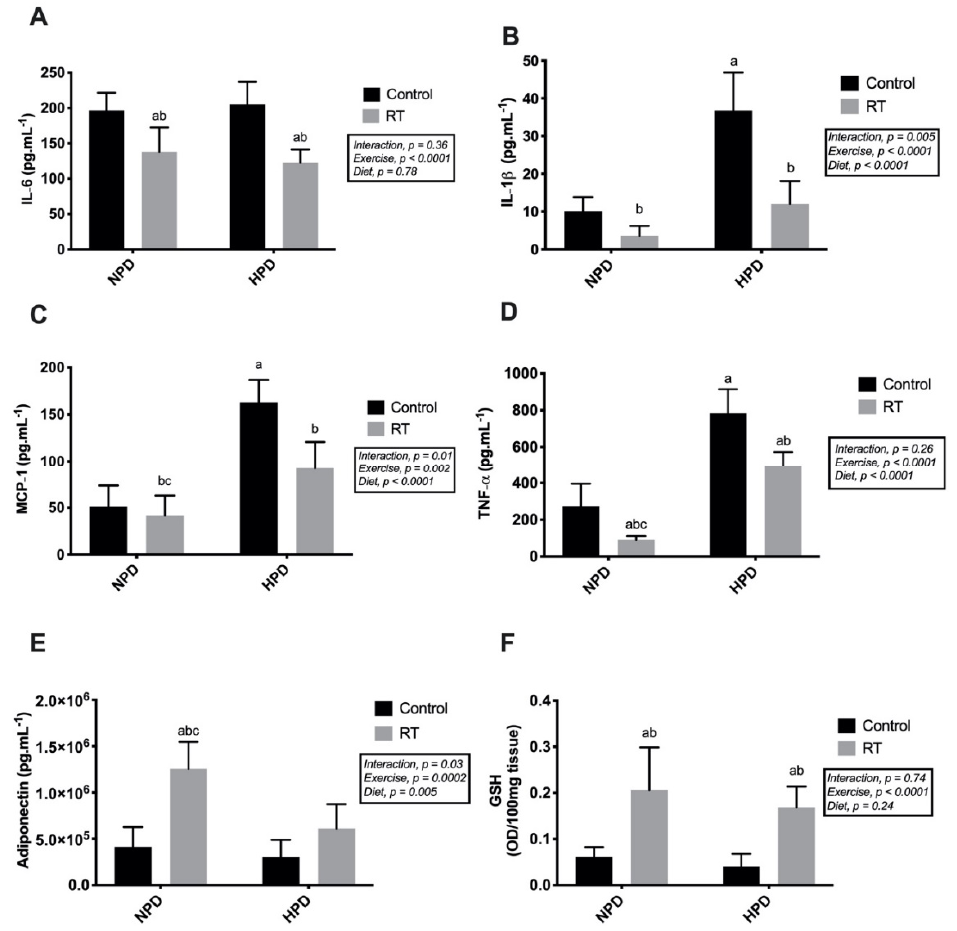
Figure 4. Inflammatory responses of epidydimal adipose tissue after 12 weeks of the experiment. ( A ) IL-6; ( B ) IL1- β ; ( C ) MCP-1; ( D ) TNF- α ; ( E ) adiponectin; ( F ) GSH. Values are presented as means ± SD. a p < 0.05 vs. NPD-Control, b p < 0.05 vs. HPD-Control, and c p < 0.05 vs.